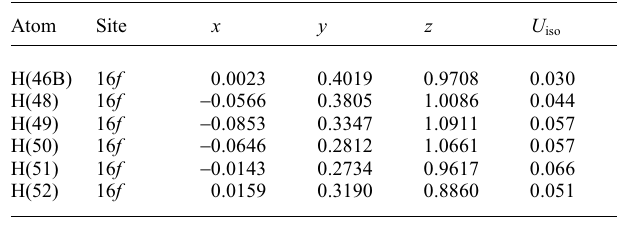
Table 3. Atomic coordinates and displacement parameters (in Å 2 )